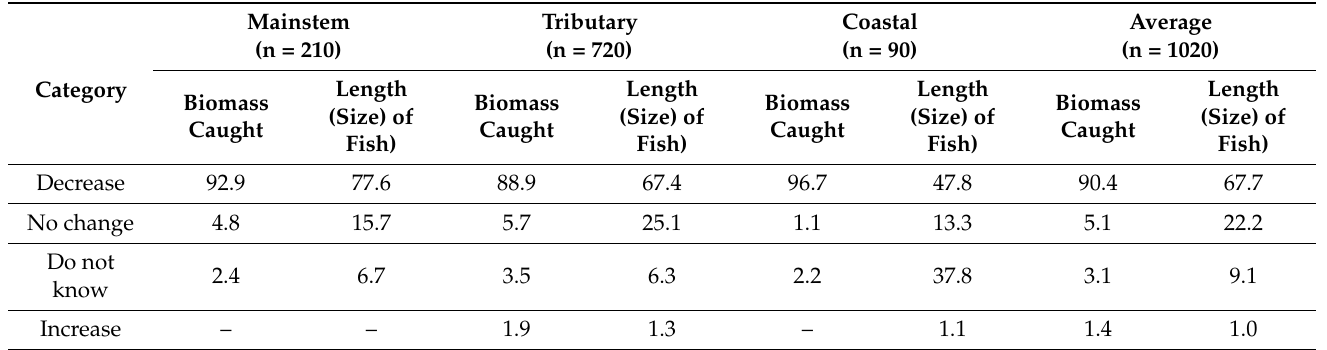
Table 2. Trend in fish catches (% of interviewees).